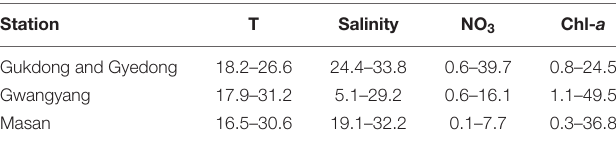
FIGURE 6 | (A,B) Chl- a peak ( µ g L − 1 ) or (C,D) peak-to-initial Chl- a ratio of the phytoplankton community as a function of the initial NO 3 ( µ M) or the ratio of initial NO 3 to Chl- a [ µ M ( µ g L − 1 ) − 1 ]. The ratio of initial NO 3 to Chl- a [ µ M ( µ g L − 1 ) − 1 ] in panels (B,D) can be described as a unitless ratio by multiplying it with 14. Data were obtained from the seven experiments incubating seawater samples collected from St. Gukdong and St. Gyedong in 2019. TABLE 2 | Equations for calculating the peak chlorophyll- a concentration (Chl- a peak, µ g L − 1 ) of the phytoplankton community and the day elapsed until the Chl- a peak occurred (Day peak ; day).